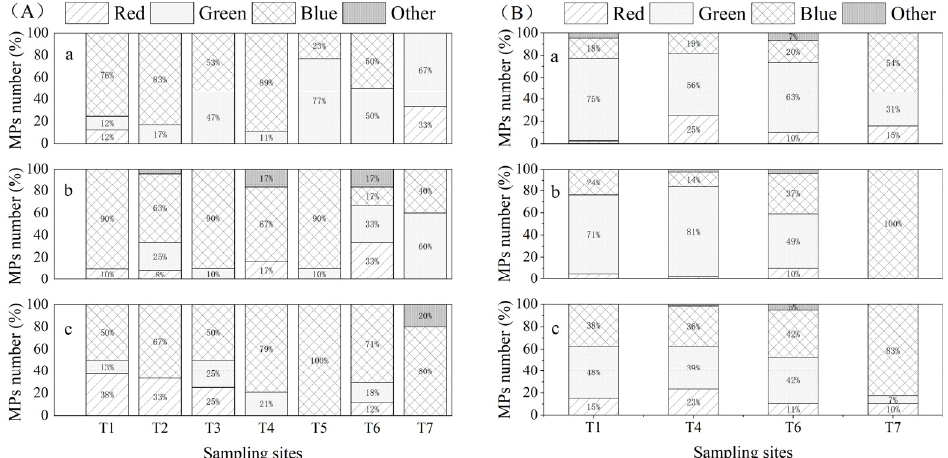
Figure 5. The proportion of microplastic color in different seasons. ( A ) denotes a water sample, while ( B ) represents a sediment sample. Proportions of various microplastic colors in the wet, typhoon, and dry seasons are represented by a, b, and c, respectively.